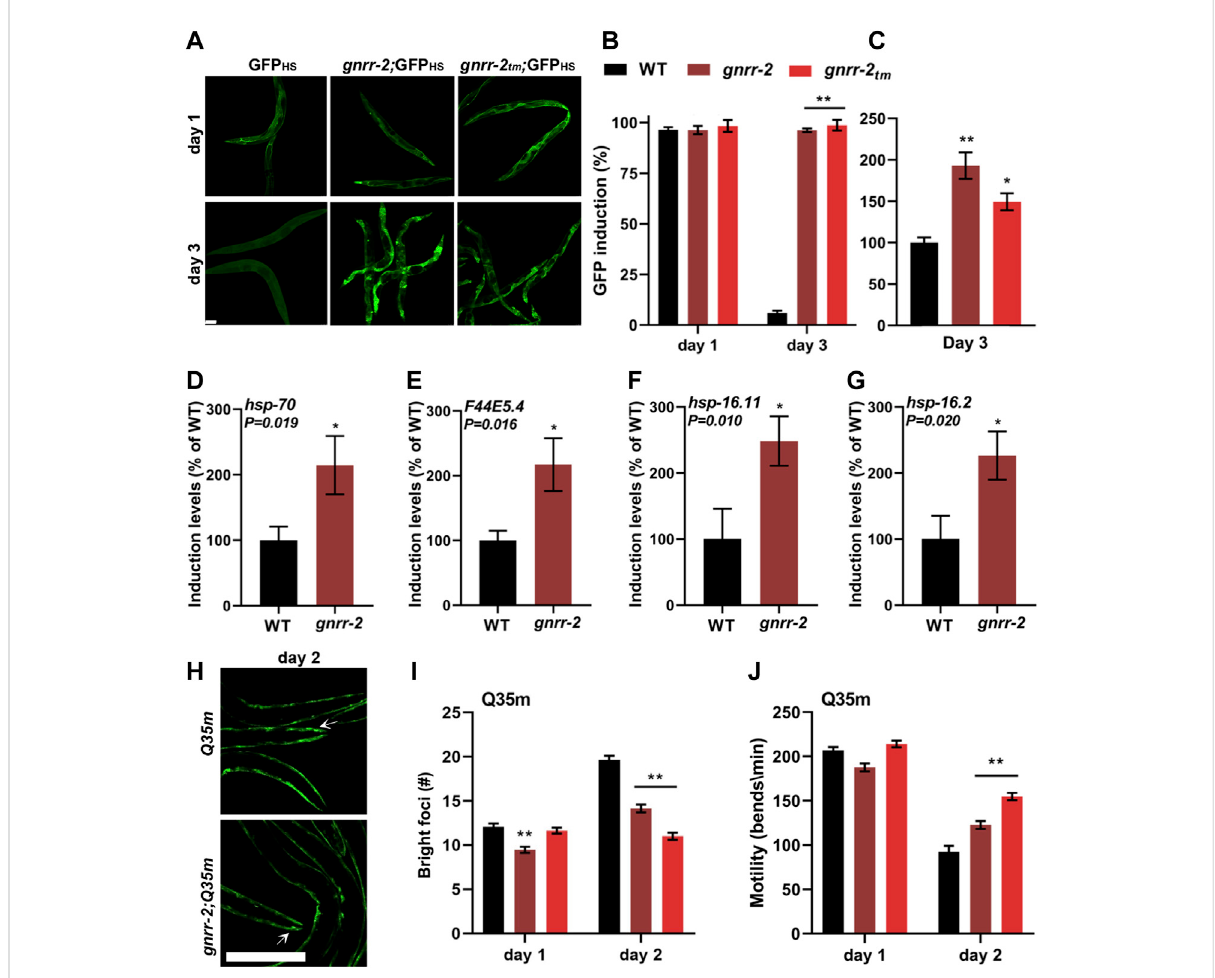
FIGURE 2 gnrr-2 modulates HS response activation in adulthood. (A – C) HS-regulated GFP HS expression. Age-synchronized WT, gnrr-2 , and gnrr-2 tm animals expressing GFP HS were imaged following a short HS 90 min at 37 ° C (A) . The percent of animals showing GFP was scored N ≥ 3 (B) , and GFP fl uorescence levels (day three adults; n > 10) were determined (C) . Data are means ±1 standard error of the mean (1 SE). Data were analyzed using one-way ANOVA followed by a Tukey ’ s post-hoc test. (**) denotes p < 0.001 compared with same-age WT animals. The scale bar is 100 µm. (D – G) Expression levels of HS genes. mRNA levels of hsp-70 (D) , F44E5.4 (E) , hsp-16.11 (F) , and hsp-16.2 (G) from age-synchronized WT or